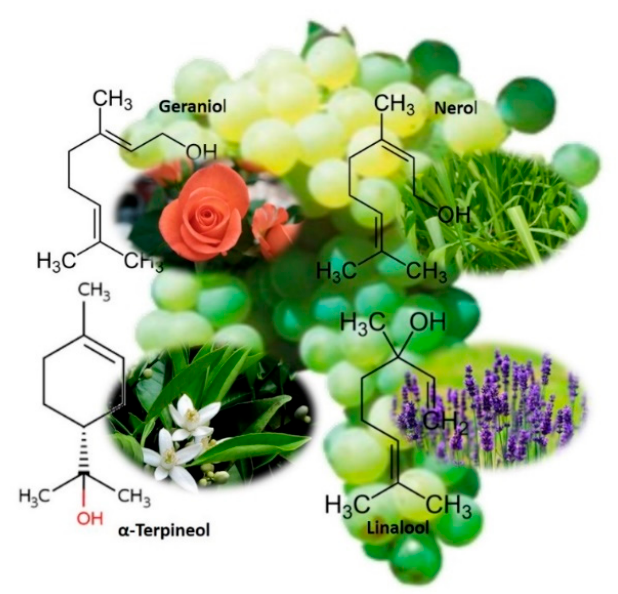
Figure 6. Set of the terpenic derivatives responsible for the aroma of Muscat grape varieties.